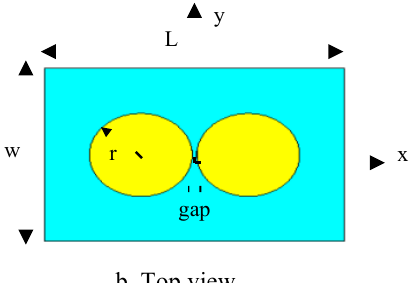
Figure 5. The detailed construction of cylindrical dipole IR nano-antenna with h=150 nm, w=5 µm, L=9 µm, r=1.5 µm, t=50 nm and gap=100 nm.